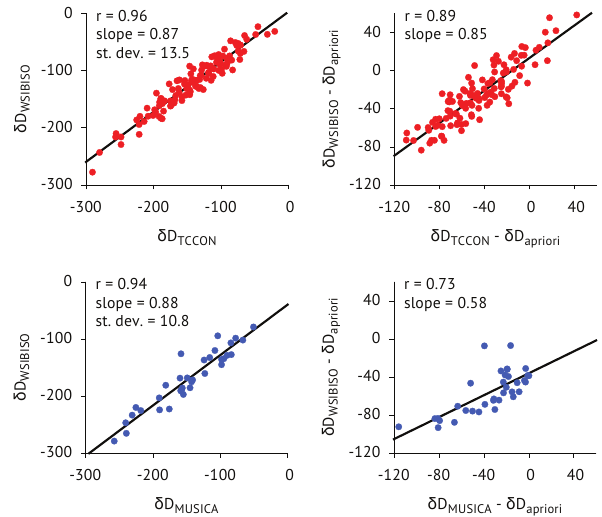
Figure 9. Daily-averaged δ D obtained from publicly available TCCON (a posteriori calculated, varying a priori) and MU- SICA/NDACC (optimally estimated, single a priori) retrievals vs. δ D obtained by using the refined set of spectral windows ( δ D WSIBISO )